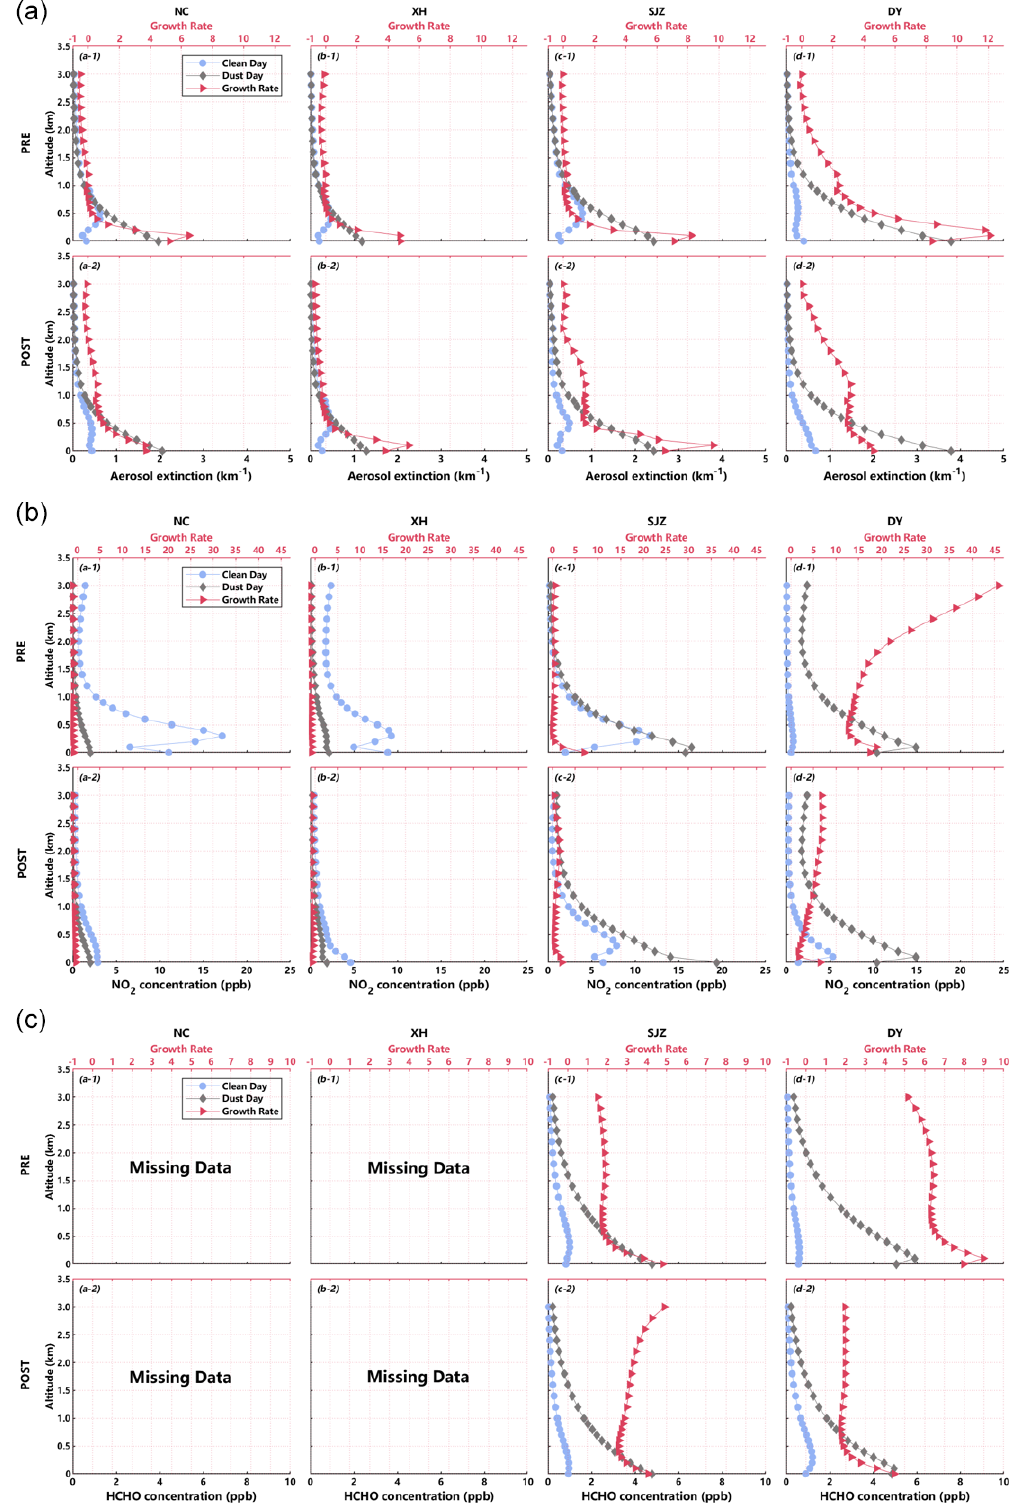
Figure 7. The growth rates of (a) AEC, (b) NO 2 , and (c) HCHO at different altitudes at (a-1–a-2) NC, (b-1–b-2) XH, (c-1–c-2) SJZ, and (d- 1–d-2) DY stations. PRE indicates pre-comparison results between 6 and 15 March 2021; POST indicates post-comparison results between 22 and 15 March